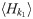
Comparison performance regarding network structural measurements and robustness performance.a) Comparison of the accuracy obtained by the proposed method (left side) and the classical network measurements (right side). The histograms on the left (mean and standard deviation) represent the best accuracies obtained when using rules B124-S257, B2478-S25 and B3567-S03468 for none-, partial- and full-dataset, respectively. In a similar way, the histograms on the right show the best accuracies obtained using the combination of the network measurements: mean degree (〈k〉), average hierarchical degree of level 1 (〈Hk1〉), average hierarchical degree of level 2 (〈Hk2〉), average clustering coefficient (〈C〉), average path length (l) and degree assortativity (Γ), as a feature vector. b) Average accuracy obtained in the variations of the original dataset. Each variation considers a different number of authors, which ranges from 2 to 8. c) Performance evaluation for different text size, ranging from 2000 to 22000 words, using rule B2478-S25. For all these experiments kNN method was used.